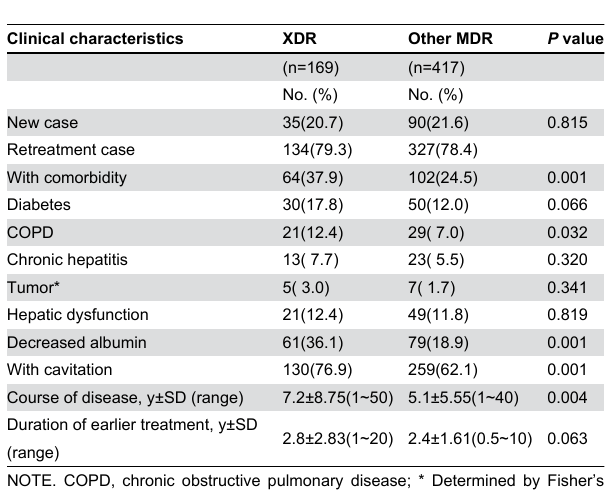
Table 2. Clinical characteristics of patients with XDR-TB and Other MDR-TB.